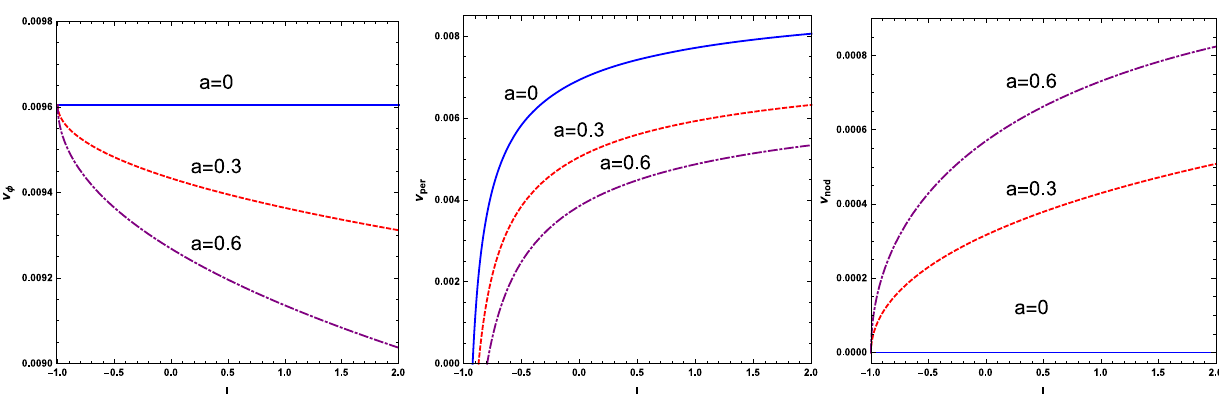
Fig. 3 The change of the second partial derivatives − ν θ with the parameter l in the rotating black hole spacetime in Einstein-bumblebee theory. Here we set M = 1 and r = 6 . 5